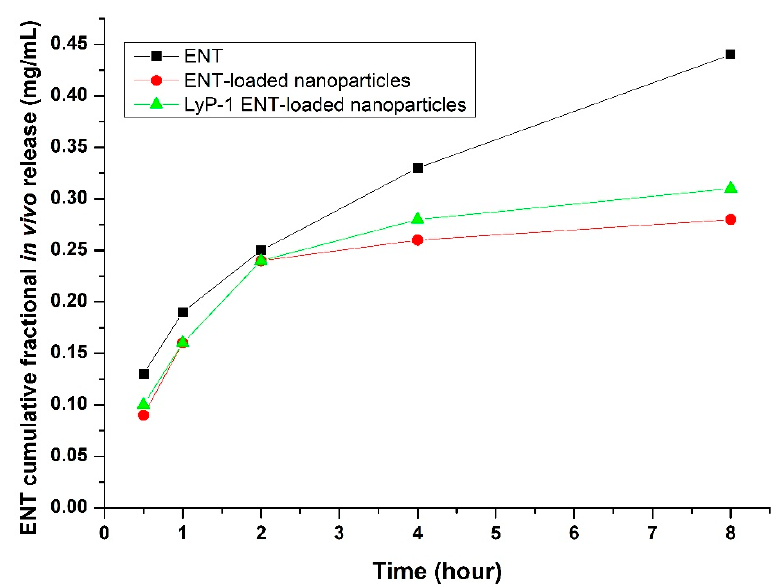
Figure 13. Plasma endostatin concentration profile depicting the release behavior over 8 h of native ENT relative to ENT-loaded nanoparticles, and the LyP-1-functionalized ENT-loaded nanosystem, SD = 0.021.